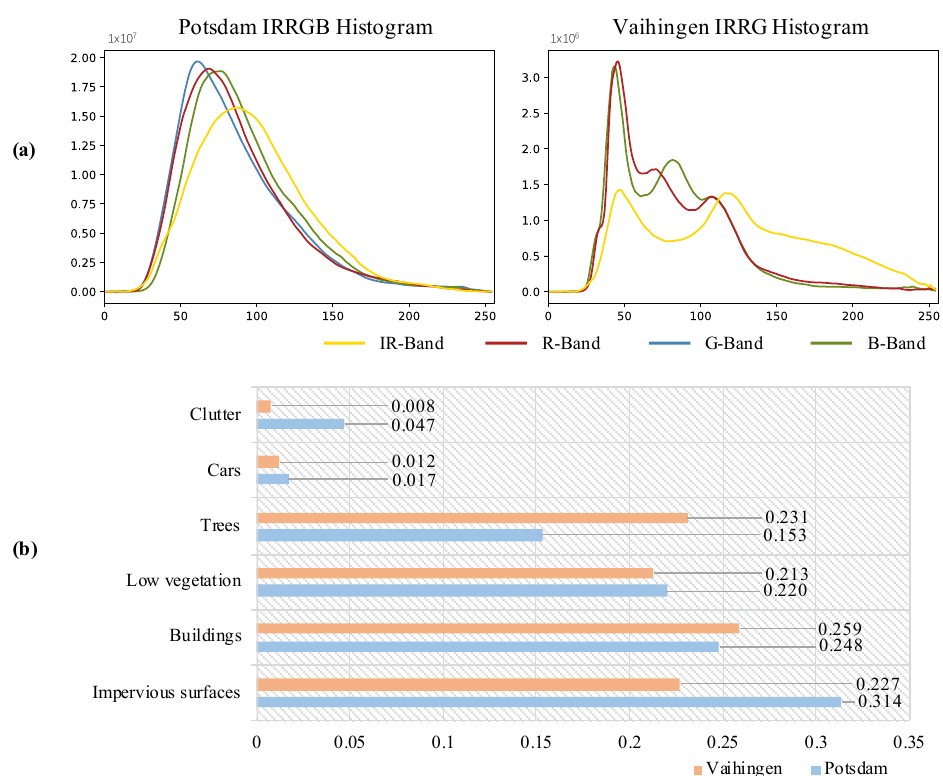
Figure 4. ( a ) The pixel value statistics of the ISPRS Vaihingen and Potsdam datasets. ( b ) The proportion of different categories from two datasets. Both of these statistic values indicate large differences between the two datasets, which make data migration